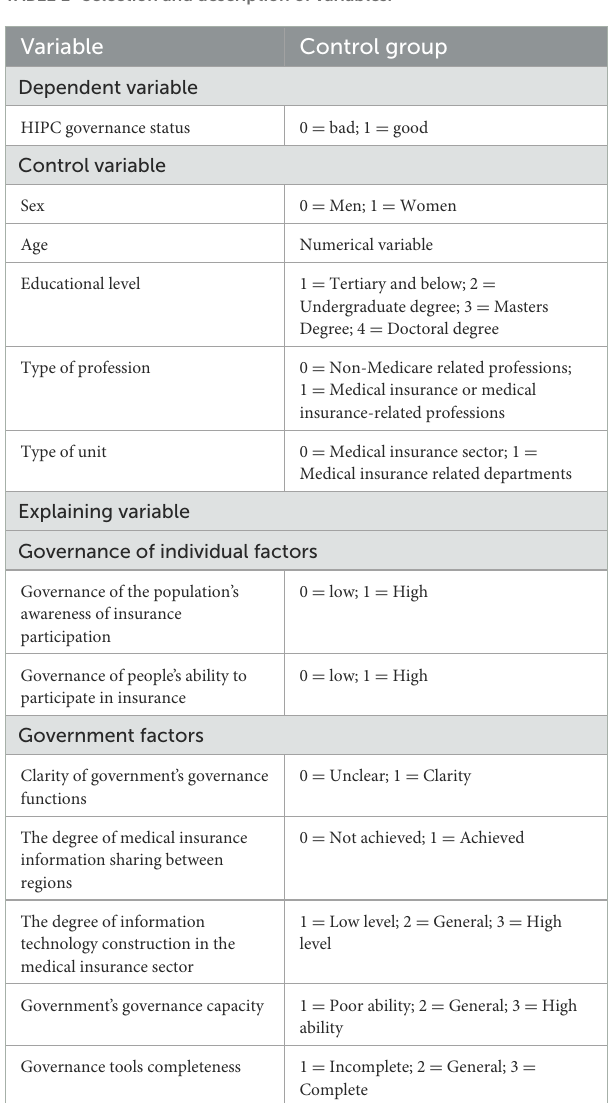
TABLE 1 Selection and description of